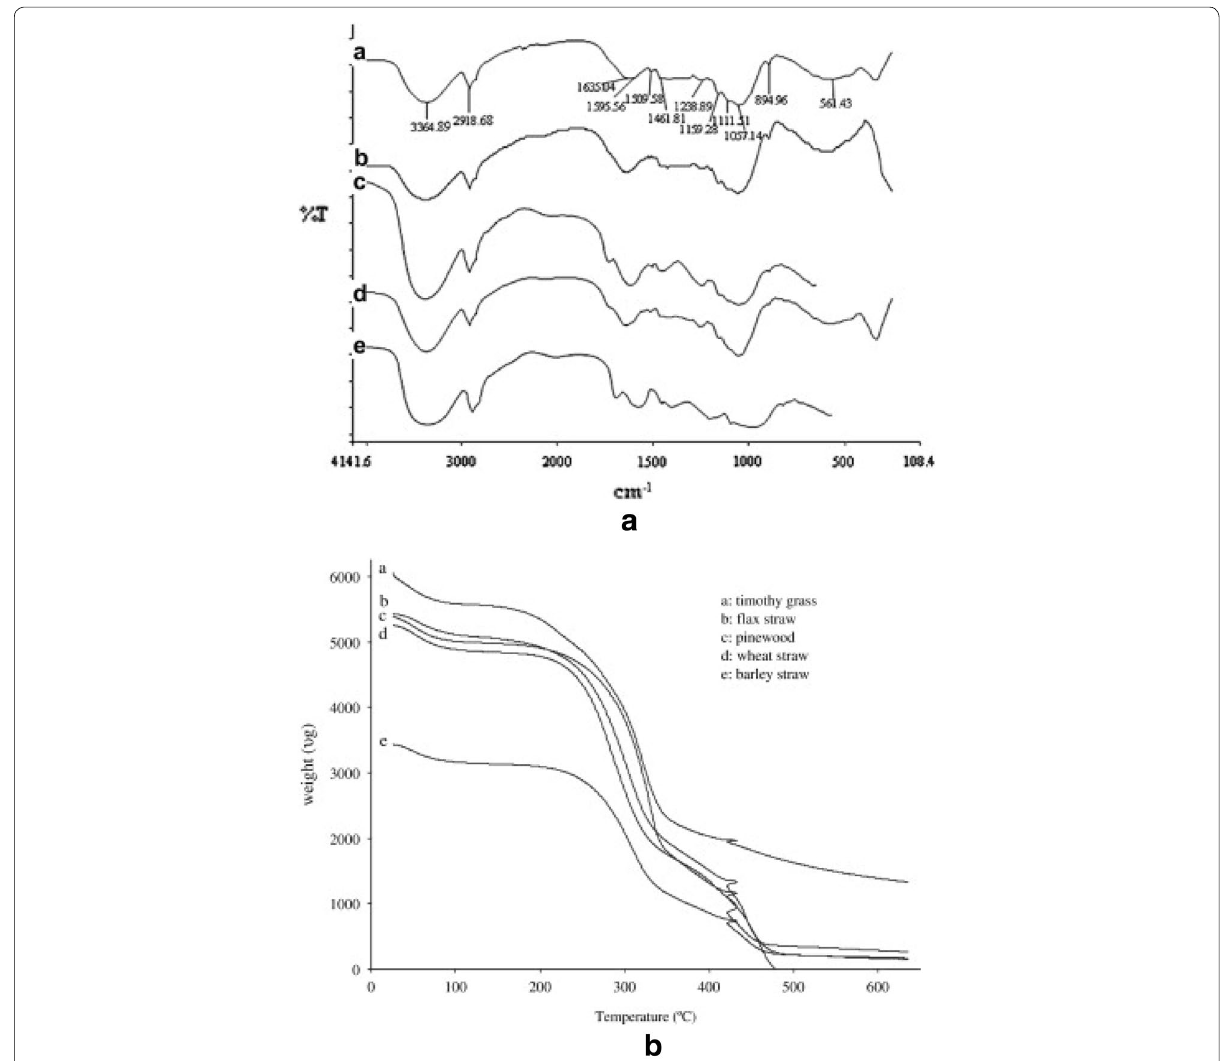
Fig. 4 Structural characterization of different biomaterials showing their key features. a FTIR spectra. b Thermogravimetric analysis [Ref. (Naik et al. 2010)] (Copyrights Elsevier, 2010. Reprinted with permission from the